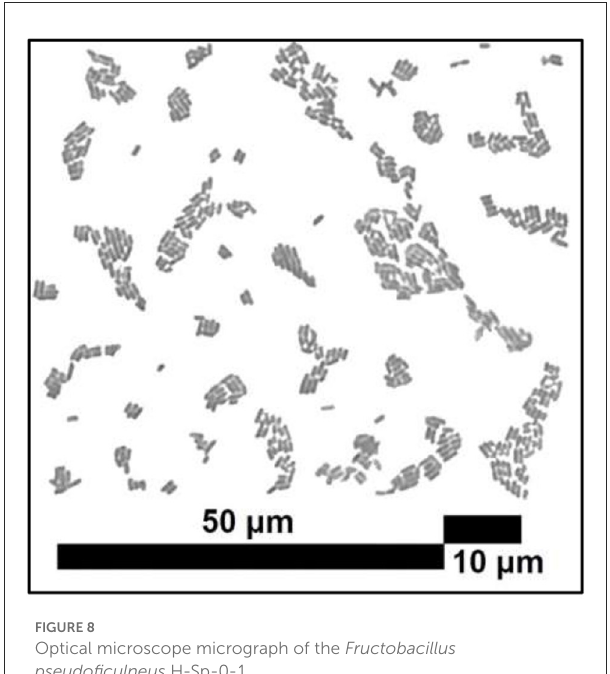
TABLE 3 Results of bacterial growth in anaerobiosis with different carbon sources with the API 50 CHL.